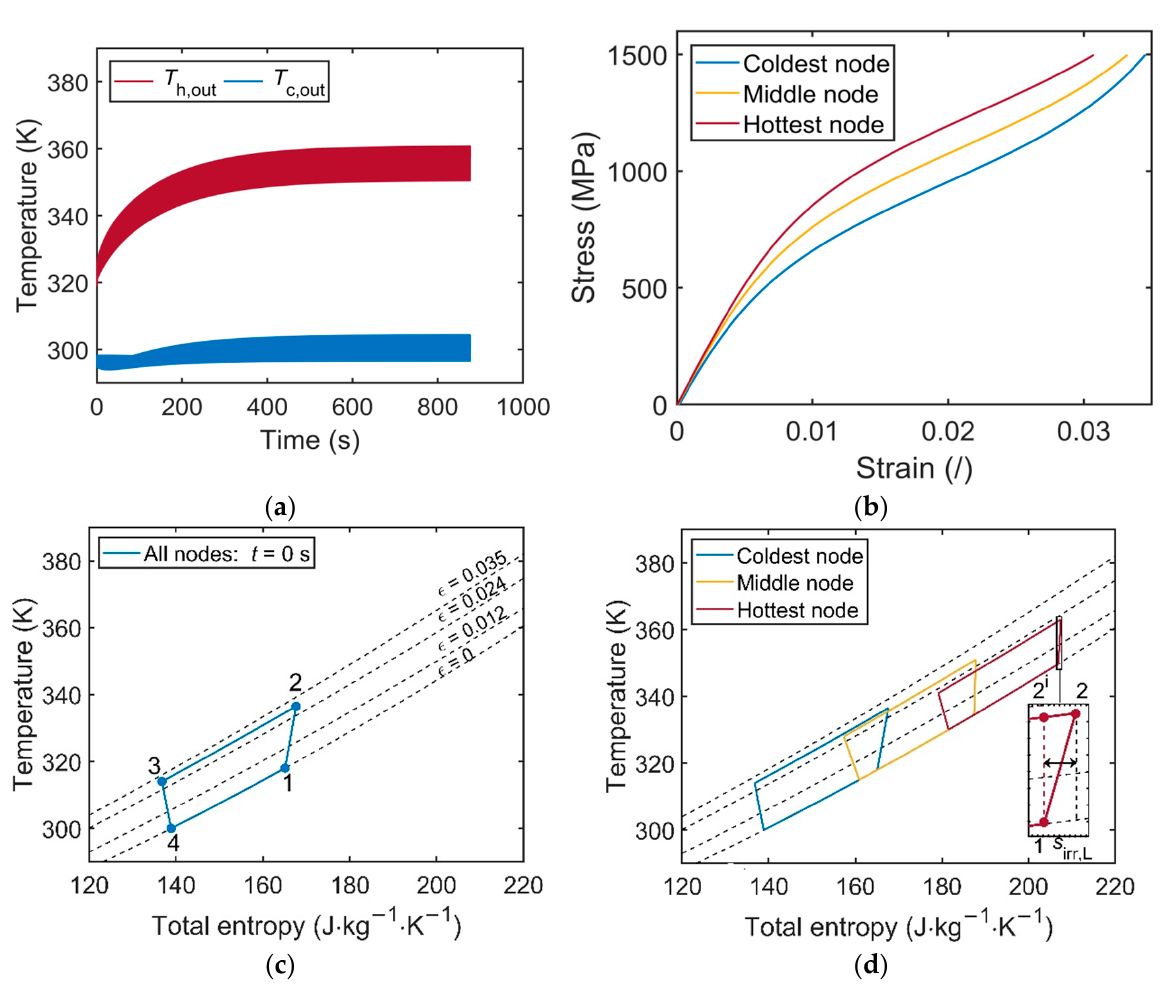
Figure 5. Time evolution of the temperature span of HTF outlet temperatures ( a ); presentation of the modeled loading curves at three different temperatures ( b ); presentation of the modeled active elastocaloric cycle in the T-s diagram with detail of the inclusion of irreversibility in the case of the first cycle ( c ) and the steady-state cycle ( d ).